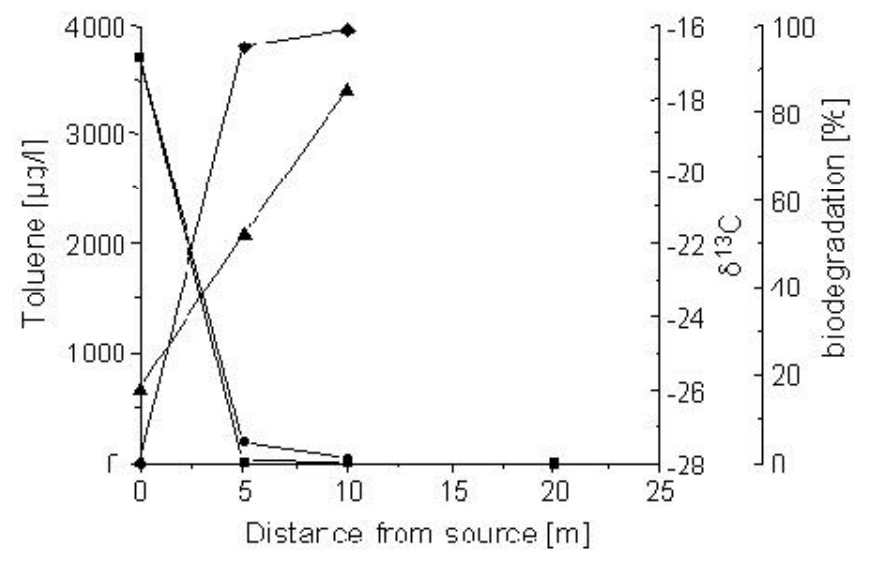
FIGURE 5. Toluene concentration (squares) and carbon isotope composition (triangles) along a monitoring profile of a contaminated site near the city of Ingolstadt, Germany. The percentage of biodegradation (diamonds) and theoretical toluene concentrations (circles) are calculated with Eqs. 4 and 5 using a carbon isotope fractionation factor for anaerobic biodegradation. (adapted from